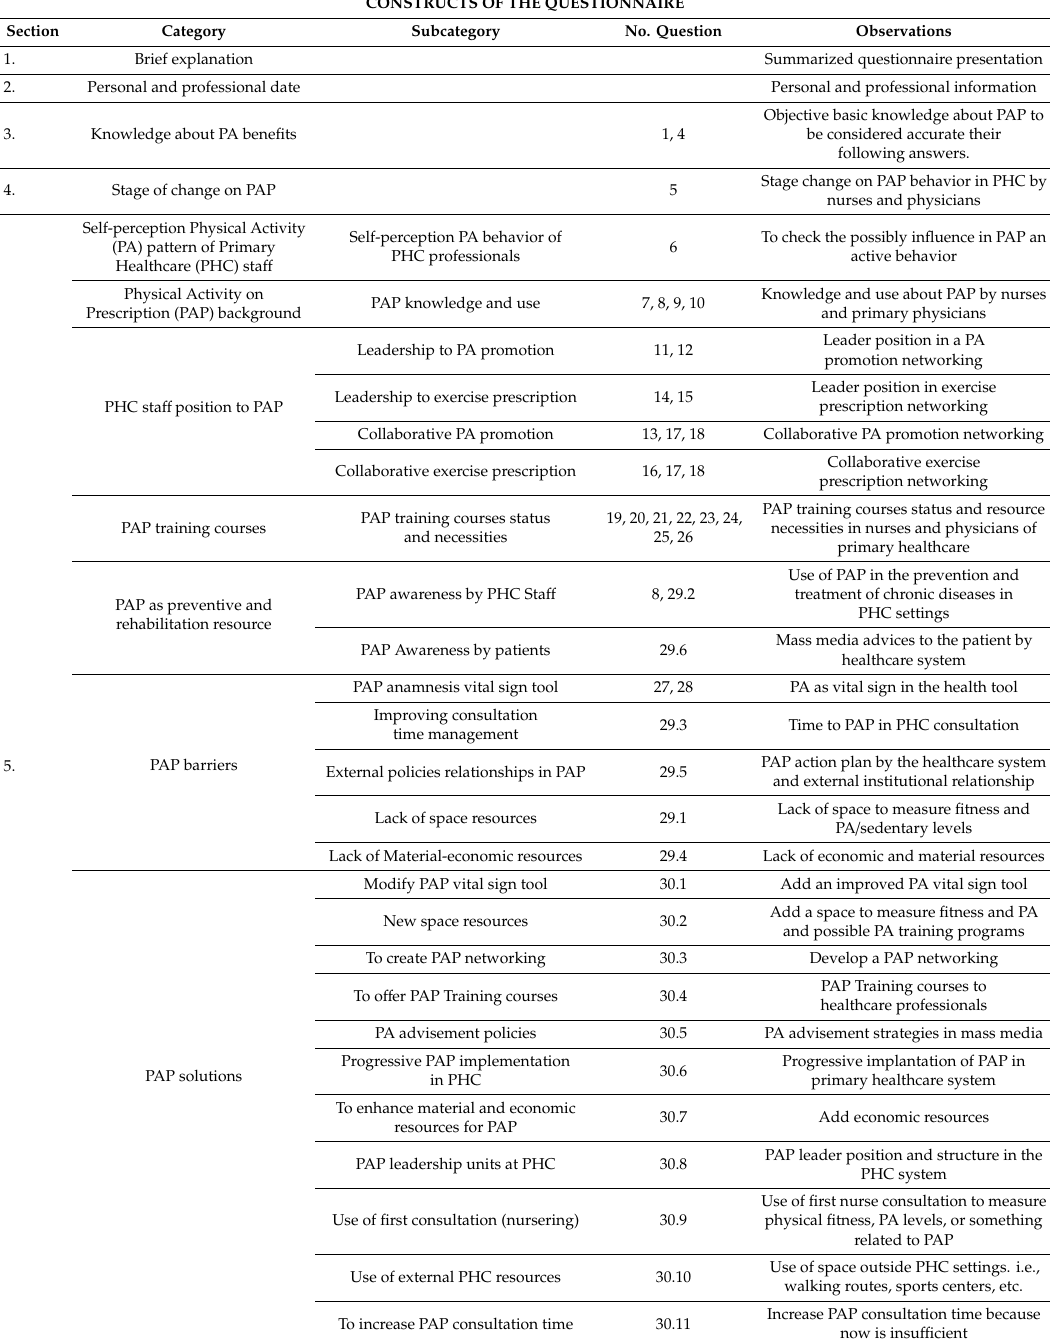
Table 1. Summarized and justified structure of the questionnaire related to each category obtained by focus groups